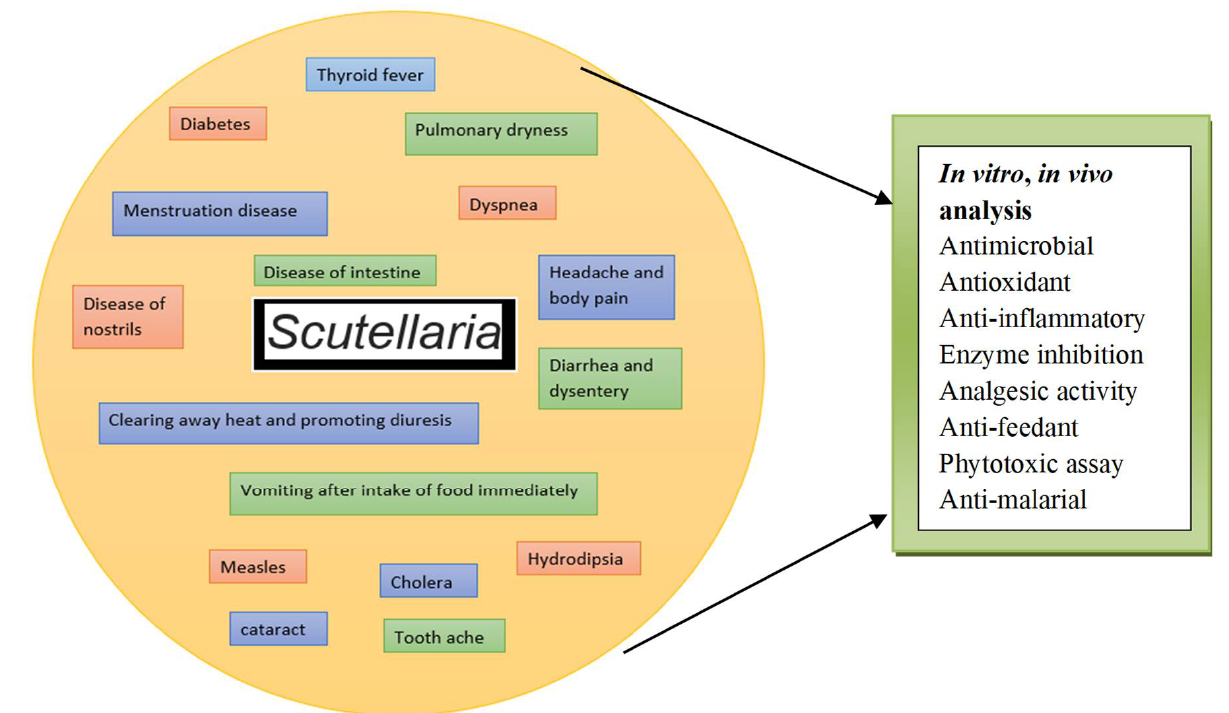
Figure 3. The traditional uses and biological activity of S. baicalensis in China.